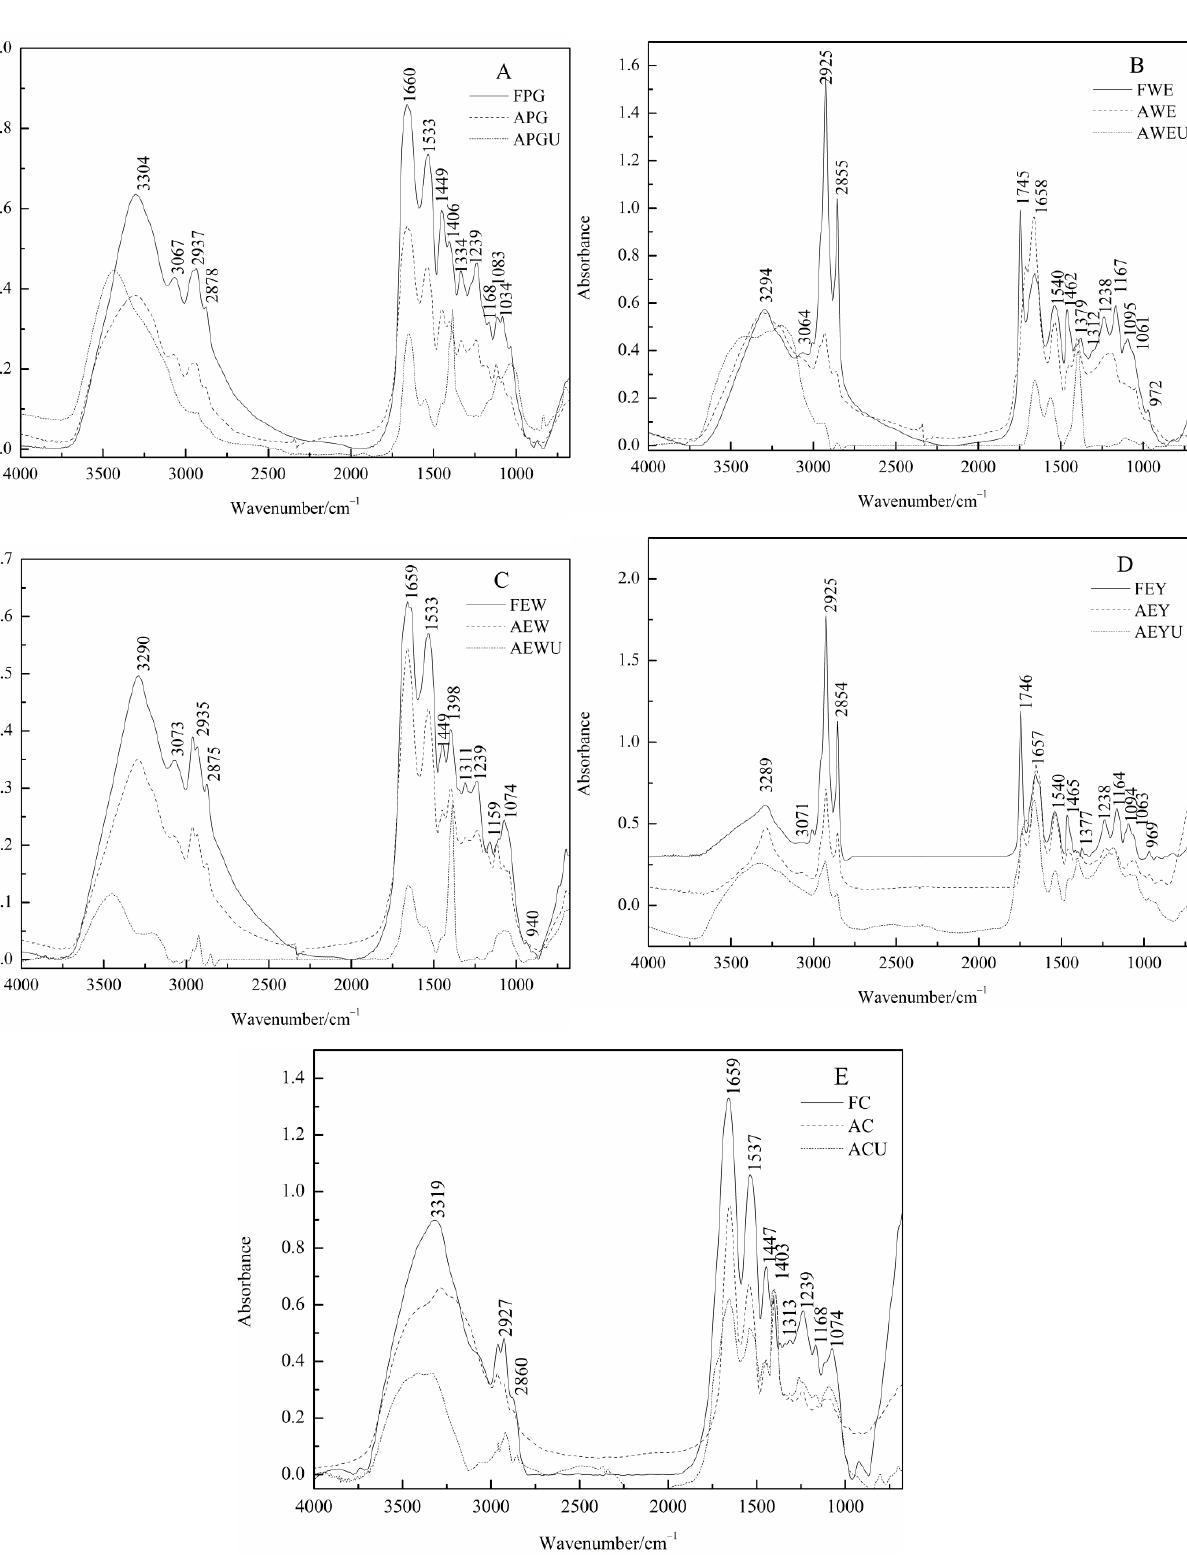
Figure 3. The FTIR spectra of the five fresh and aged binders (( A ) pig glue; ( B ) whole egg; ( C ) egg white; ( D ) egg yolk; ( E ) casein). Table 3. The absorbance characteristics of the five fresh and aged binders. Region